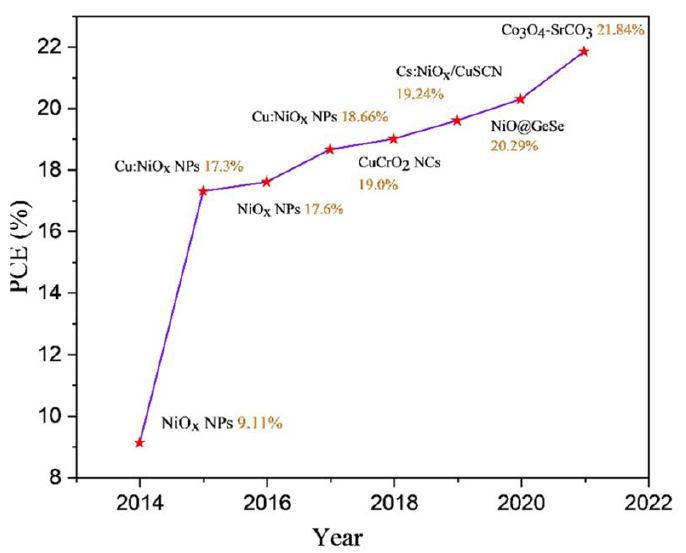
Figure 2. The PCEs evolution of PSCs with nanostructured inorganic HTLs [60-67].